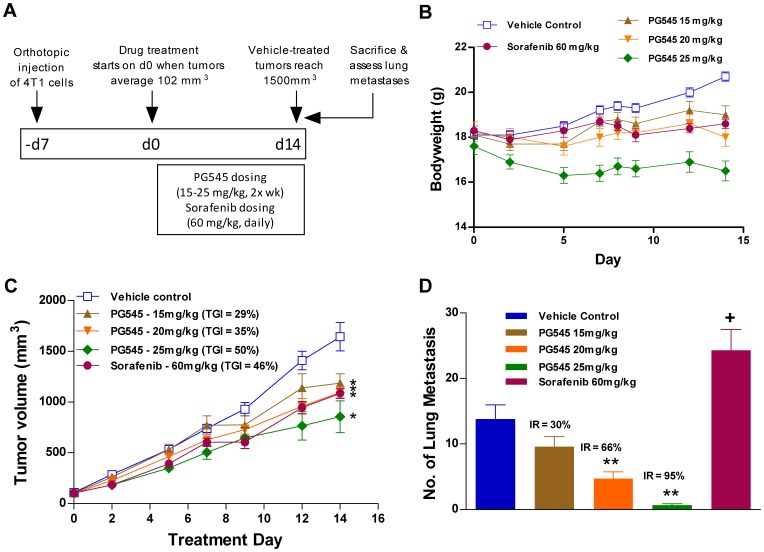
PG545 inhibits primary tumor growth and spontaneous metastasis to lung in 4T1 breast cancer model.(A) Experimental protocol for the orthotopic 4T1 primary tumor and spontaneous metastasis model. Female Balb/c mice were injected with 10 µL of 5×105 4T1 cells into the third mammary fat pad. Twice-weekly treatment with PG545 commenced once the primary tumors reached a size of approximately 100 mm3 (n = 10). (B) Twice weekly treatment with PG545 at 25 mg/kg led to a non-significant bodyweight loss of 4.7% by day 14. (C) PG545 significantly inhibited the growth of the primary 4T1 tumor. The study ended on treatment day 14 due to serious clinical signs in some groups. (D) On treatment day 14, mice were examined for the presence of metastasis in the lungs and a dose-dependent inhibitory effect with PG545 was apparent while sorafenib significantly increased the number of lung metastases. A one-way ANOVA was performed on tumor volumes or surface lung metastases counts measured in all surviving mice at the end of the study followed by either a Holm-Sidak method or Dunn’s Method were performed. * = P<0.05, ** = P<0.01 for PG545-treated groups versus vehicle control and + = P<0.05 for sorafenib-treated group versus vehicle control.